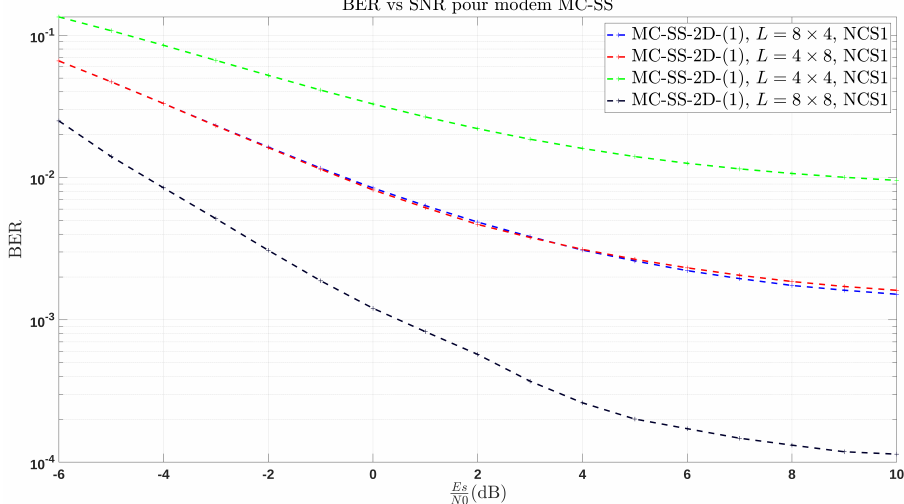
Figure 9. BER vs. Es for a communication on NCS1 (Norway Continental Shelf) channel [20] N 0 (frequency passband: 10.5 kHz–14.5 kHz).